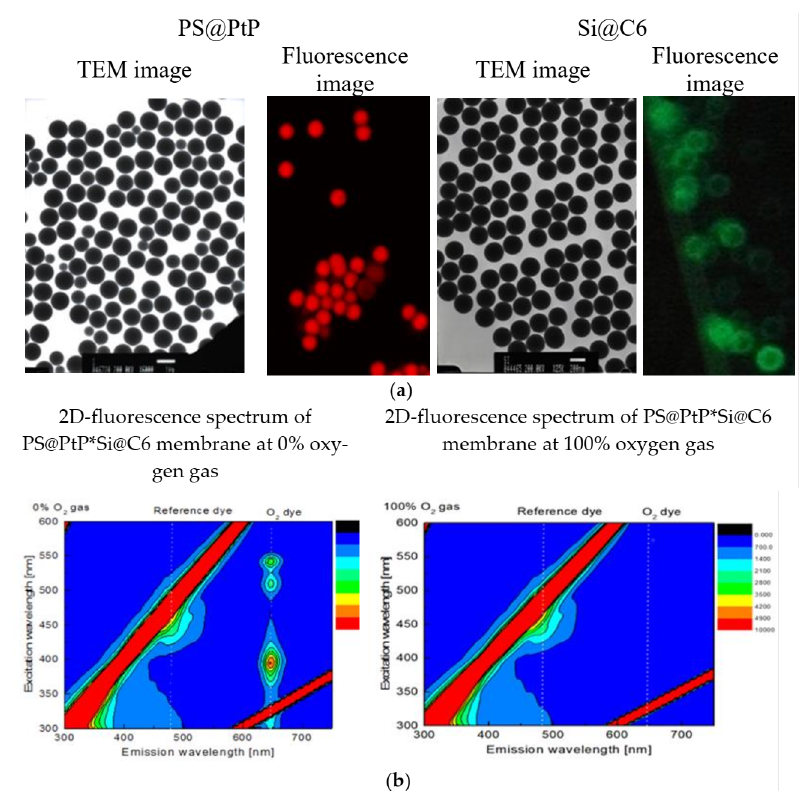
Figure 1. ( a ) TEM and fluorescence images of PS@PtP with a scale bar of 1 µ m and Si@C6 with a scale bar of 200 nm; ( b ) 2D-fluorescence spectra of the PS@PtP*Si@C6 membrane to 0% and 100% oxygen